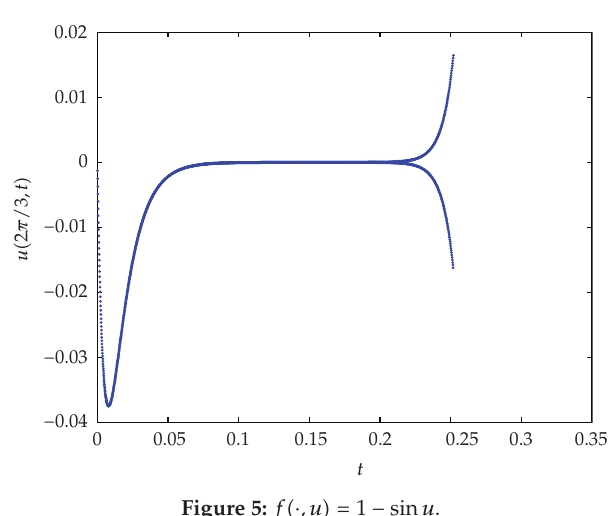
Figure 5: f (cid:6) · ,u (cid:7) (cid:5) 1 − sin u